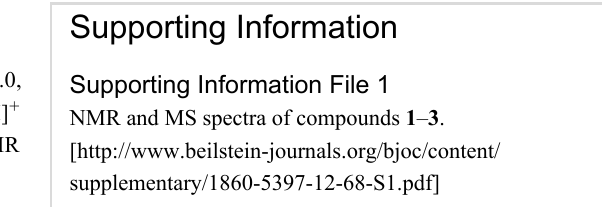
Compound 2 : colourless gum; IR λ max (cm − 1 ): 3396.4, 2924.4, 2872.4, 1704.7, 1458.8, 1364.4, 1266.2, 1221.3, 1074.8, 1036.4; ESI–HRMS m / z 411.2013 [C 21 H 30 O 8 + H] + (calcd.